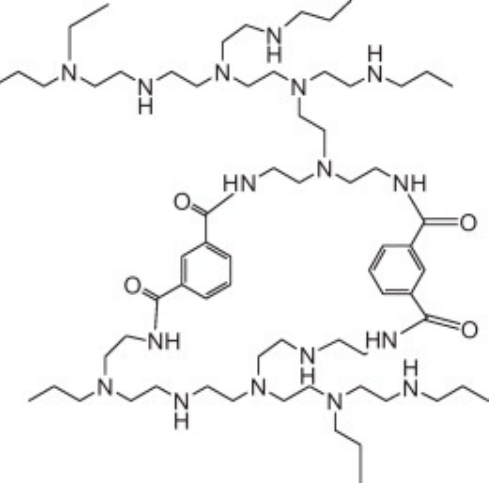
Figure 5. Possible chemical structure of the interfacially polymerized network formed with hyperbranched polyethyleneimine and isophthaloyl chloride